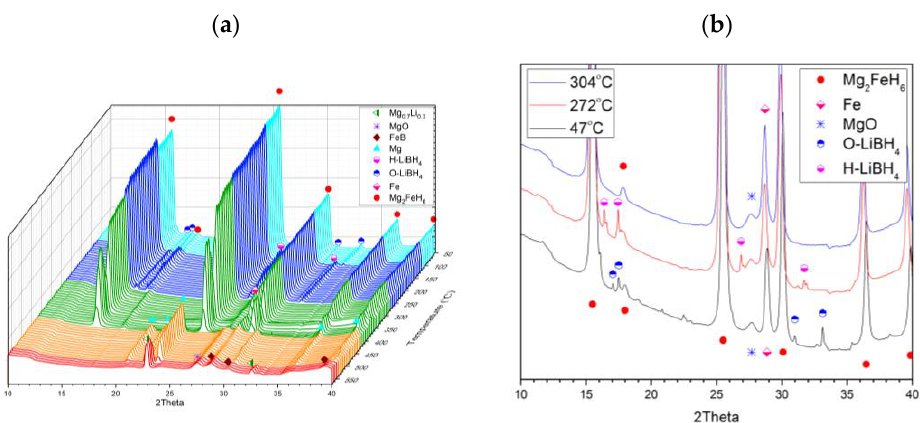
Figure 3. ( a ) In situ synchrotron XRD patterns of 2LiBH 4 –Mg 2 FeH 6 in dissociation under vacuum (5 ◦ C/min heating). Performed at Lund ( λ = 0.99242 Å). ( b ) Phase change and melting of LiBH 4 .